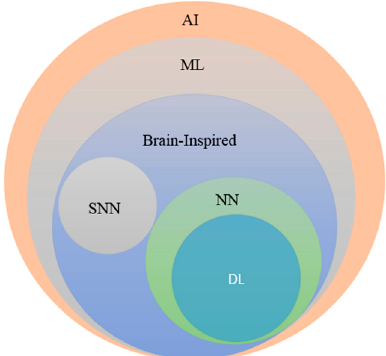
Figure 1. The taxonomy of AI. AI: Artificial Intelligence; ML: Machine Learning; NN: Neural Networks; DL: Deep Learning; SNN: Spiking Neural Networks.